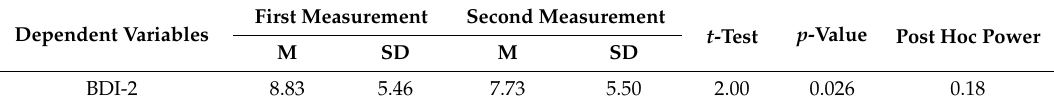
Table 4. The results of severity of depressive symptoms (Beck Depression Inventory (BDI-2)) before and after 12 weeks of the Nordic Walking training program.